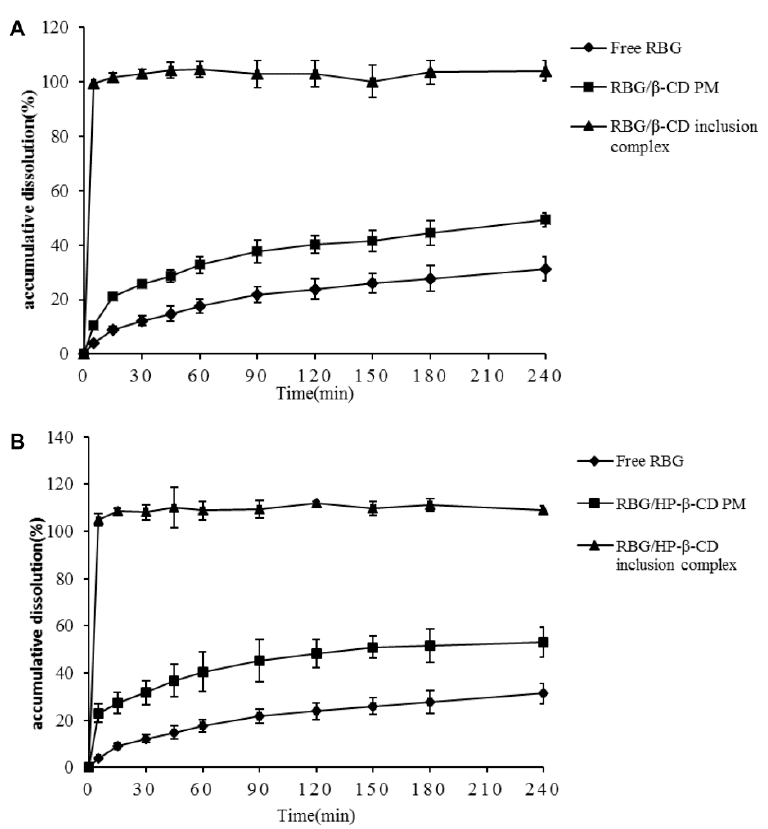
Figure 7. Dissolution profiles of RBG, RBG/ β -CD PMs, RBG/ β -CD inclusion complexes ( A ), RBG/HP- β -CD PMs, and RBG/HP- β -CD inclusion complexes ( B ) in PBS (pH 6.8) at 37 °C.